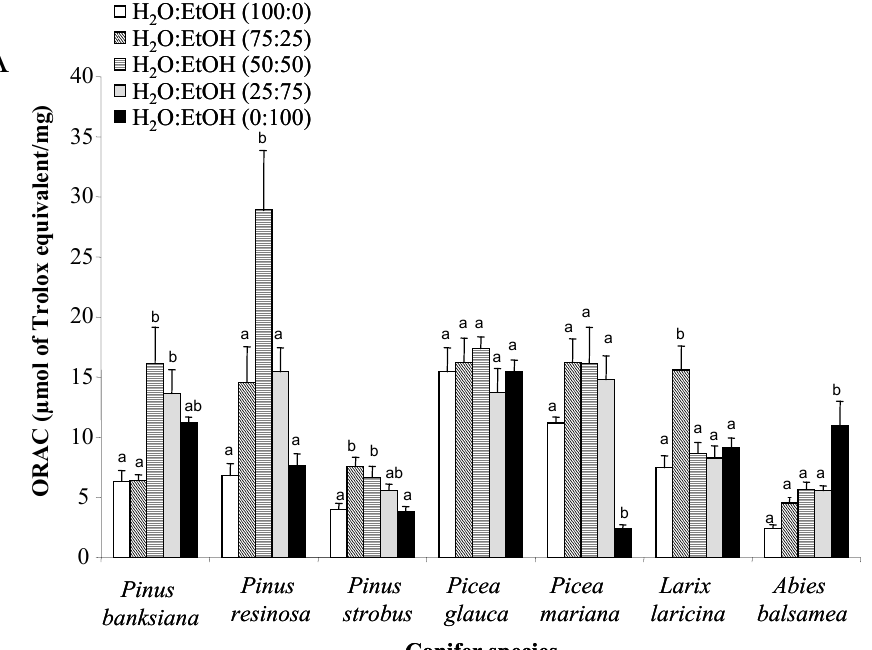
Figure 1. Antioxidant activity of conifer bark extracts using ( A ) ORAC assay and ( B ) cell-based assay. ORAC values are expressed as micromoles of Trolox equivalent per milligram of dry extract. IC values obtained using cell-based assay were expressed as the 50 concentration inhibiting fifty percent of DCFH oxidation induced by tert -butyl hydroperoxide. The ORAC value and IC of the positive control, pycnogenol, are 5.4 ± 0.3 μmol TE/mg 50 and 1.5 ± 0.2 μg/mL respectively. All assays were conducted in triplicate, and the mean values are used. The vertical bars represent the standard deviation of each data point. Means within each group with different letters (a–c) differ significantly ( p < 0.05) from each